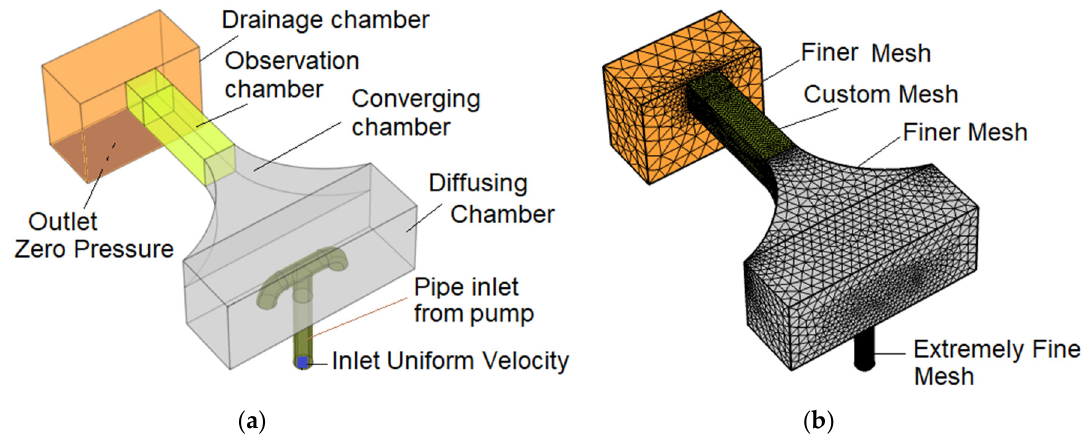
Figure 4. Panel ( a ) shows the computational domains involved in the analysis and panel ( b ) shows the non-uniform mesh generation implemented for the analysis.